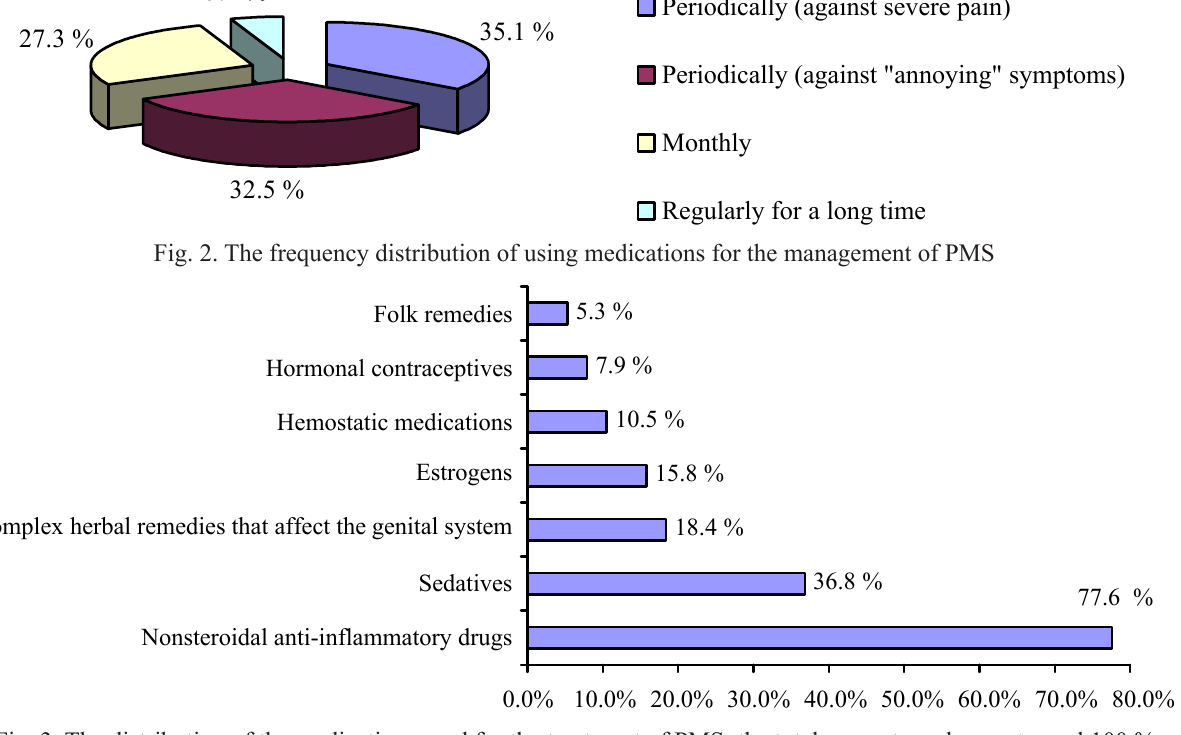
Fig. 3. The distribution of the medications used for the treatment of PMS: the total percentage does not equal 100 % because the responders could choose a few answers